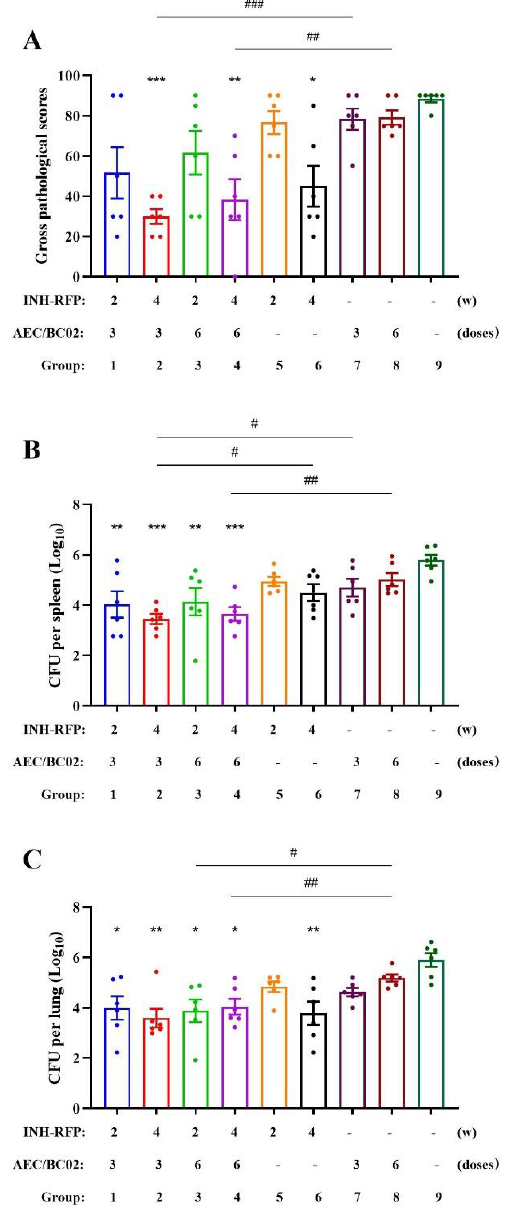
Figure 3. Effects of different immunotherapy procedures on the gross pathological score and bacterial loads (mean ± SEM). ( A ) shows the gross pathological scores for the spleen, lung and liver; ( B ) shows the bacterial loads of the spleen tissue; ( C ) shows the bacterial loads of the lung tissue. * indicates that the experimental group was compared with the NS group, and # indicates that the experimental group was compared with the designated group. */ # p < 0.05, **/ ## p < 0.01, ***/ ### p <